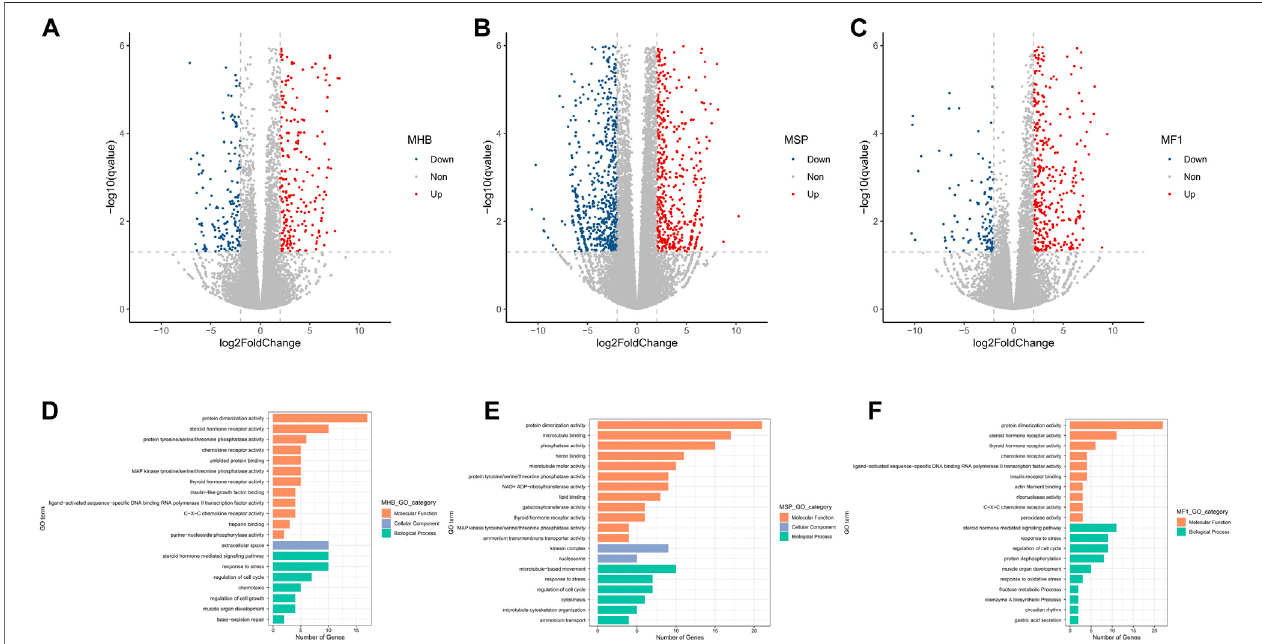
FIGURE 2 | Volcano plot of log2 fold change and -log10 (FDR) of the differentially regulated genes demonstrated that most of the genes were up-regulated in all three strains of carp muscle. (A) Volcano plot for Hebao red carp muscle DEGs (MHBN1, MHBN2, MHBN3, MHBN4, MHBN5, MHBH1, MHBH2, MHBH3, MHBH4, MHBH5). (B) VolcanoplotforSongpumirrorcarpmuscleDEGs(MSPN1,MSPN2,MSPN3,MSPN4,MSPN5,MSPH1,MSPH2,MSPH4,MSPH5,MSPH6). (C) Volcano plot for hybrid F1 carp muscle DEGs (MF1N1, MF1N2, MF1N3, MF1N4, MF1N5, MF1H1, MF1H2, MF1H3, MF1H4, MF1H5). GO enrichment analysis for genes differentially expressed between normoxia and hypoxia groups. (D) . Signi fi cantly enriched GO terms are shown for hypoxia-stressed Hebao red carp muscle. (E) . Signi fi cantlyenriched GOterms areshownforhypoxia-stressedSongpumirrorcarpmuscle. (F) .Signi fi cantlyenriched GOterms areshownforhypoxia-stressedhybrid F1 carp